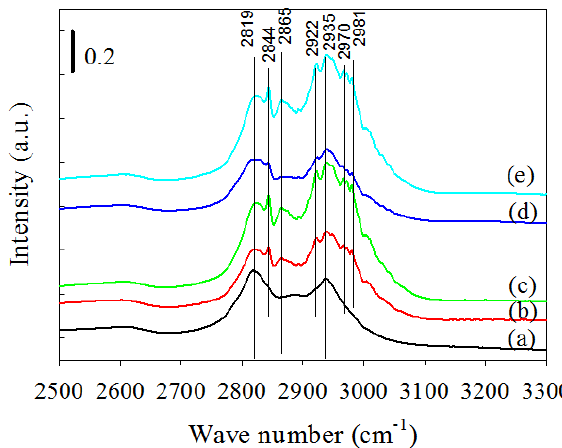
Figure 7. In situ DRIFT spectra of Au/La 2 O 3 /Al 2 O 3 catalysts after methanol adsorption at 160 ◦ C and subsequent He purge for 5 min: ( a ) La 2 O 3 /Al 2 O 3 ; ( b ) Au/La 2 O 3 /Al 2 O 3 (H); ( c ) Au/La 2 O 3 /Al 2 O 3 (S35); ( d ) Au/La 2 O 3 /Al 2 O 3 (S115); ( e ) Au/La 2 O 3 /Al 2 O 3